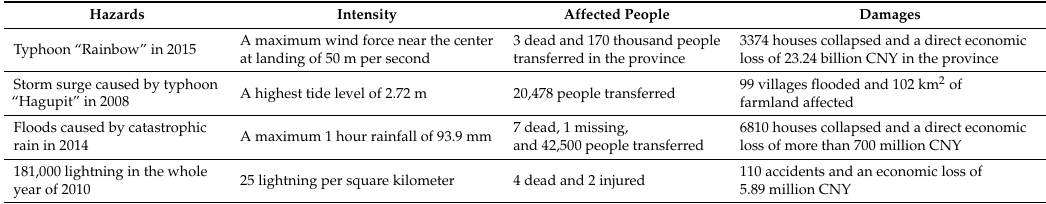
Figure 1. Location of ( a ) Guangdong Province in China; ( b ) Guangzhou (study area) and ( c ) 11 districts in Guangzhou. Table 1. Main hazards in the study area and their characteristics.